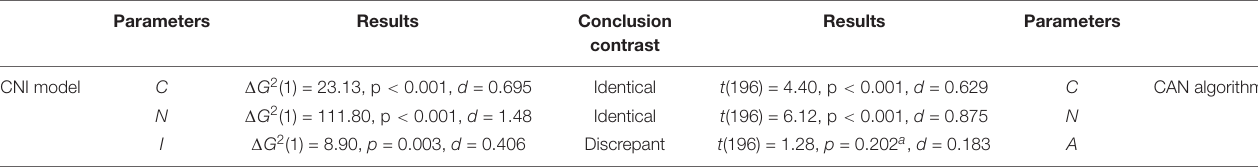
TABLE A6 | Test of psychopathy differences with the CNI model and CAN algorithm in Study 4b by Gawronski et al. (2017). Parameters Results Conclusion